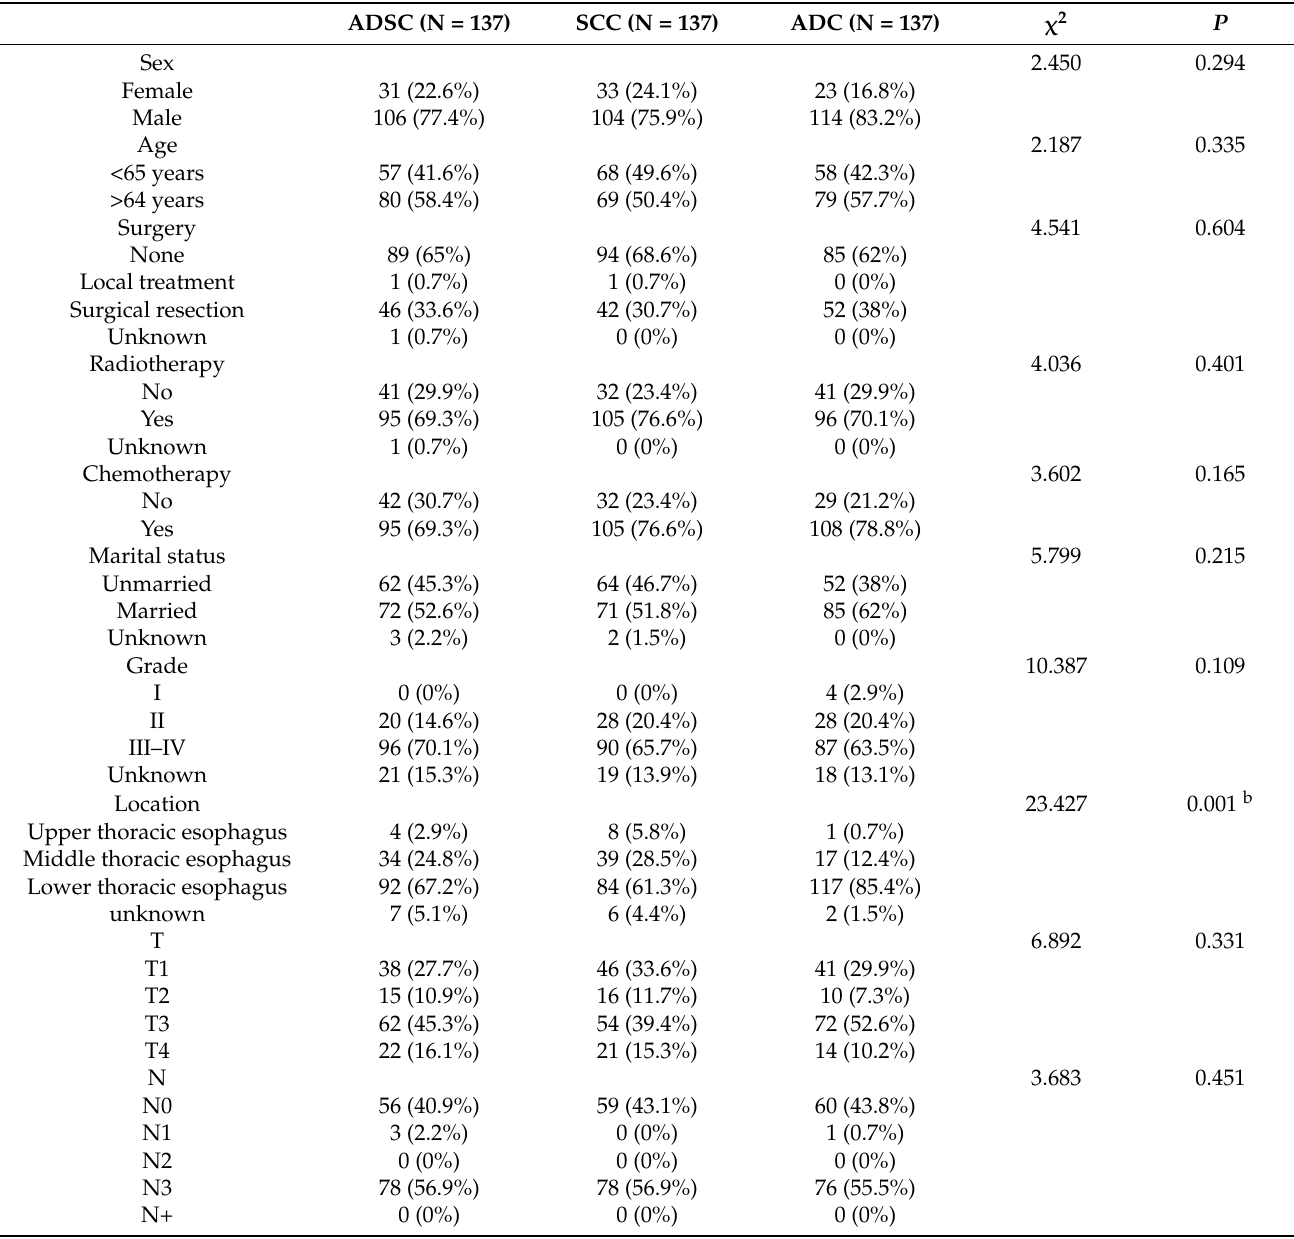
Table 2. Demographic and clinical characteristics of the three groups after PSM (N